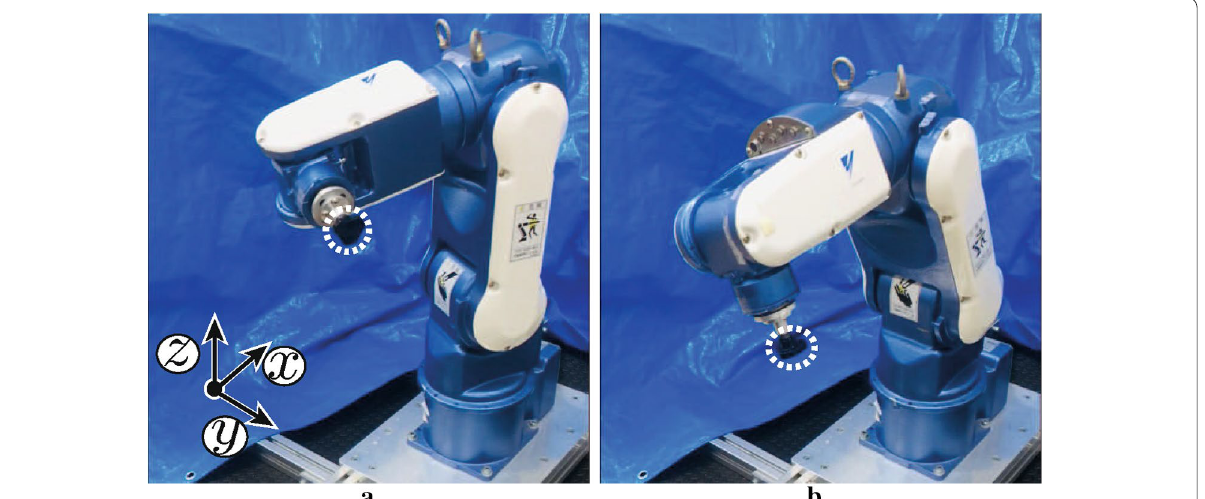
Fig. 6 Situations of Experiment II. a Configuration D ( p d = [ 0.3,0.01,0.5 ] T m , ˜ α d = [ 0.592,0.449,0.296 ] T ). b Configuration E ( p d = [ 0.36,0.06,0.4 ] T m , ˜ α d = [ 0.178,0.711,0.088 ] T